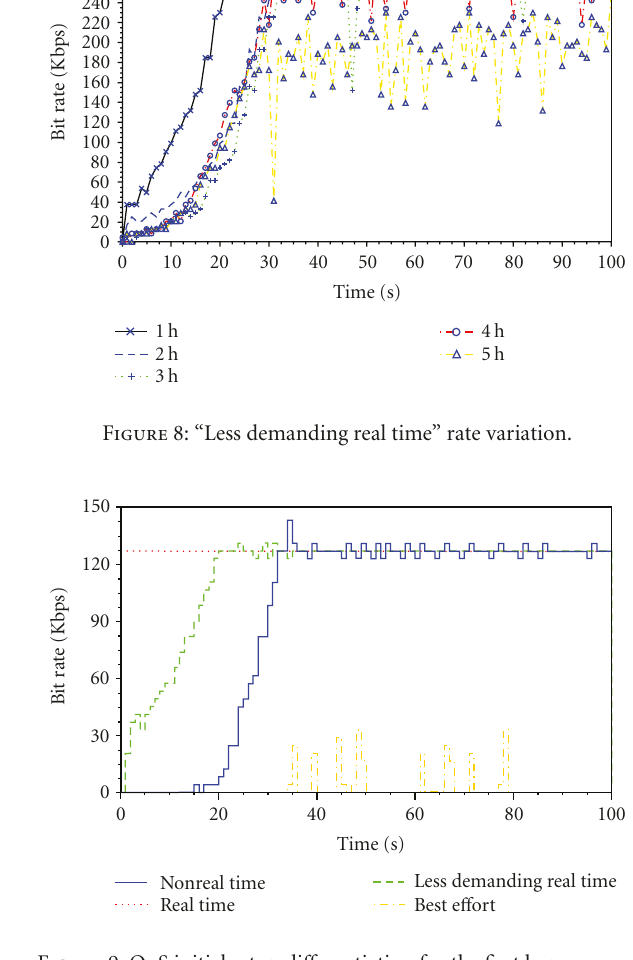
Figure 9: QoS initial setup di ff erentiation for the first hop connec-